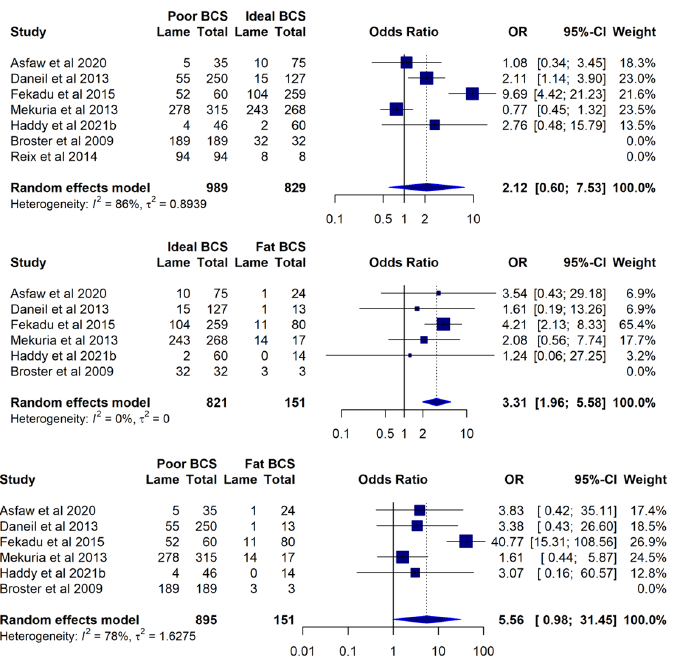
Figure 5. A meta-analysis of studies investigating working equid lameness in low- and middle-income countries from 2003 to 2021, with available data for the prevalence of lameness per body condition score (BCS) category: Asfaw et al. 2020 [79], Daneil et al. 2013 [52], Fekadu et al. 2015 [49], Mekuria et al. 2013 [80], Haddy et al. 2021b [34], Broster et al. 2009 [11], Reix et al. 2014 [12]. Reference categories are listed on the right .